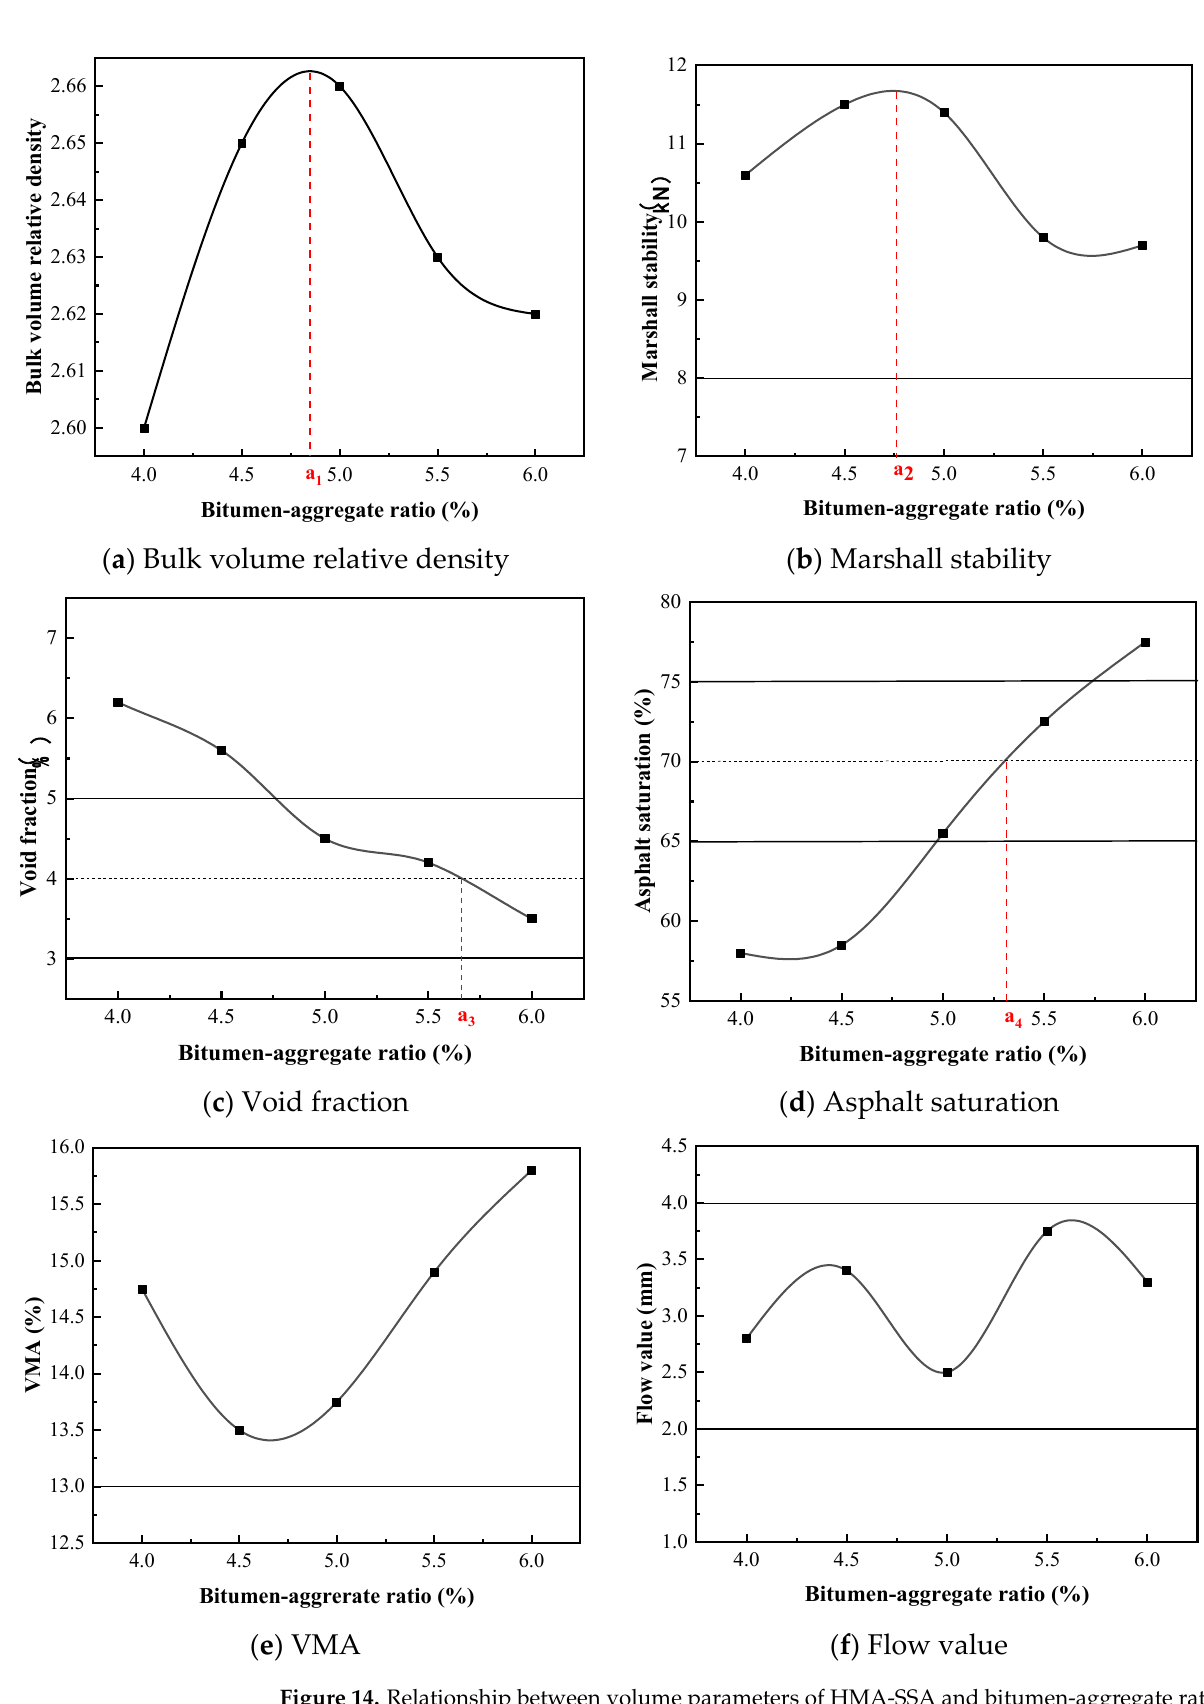
Figure 14. Relationship between volume parameters of HMA-SSA and bitumen-aggregate ratio.